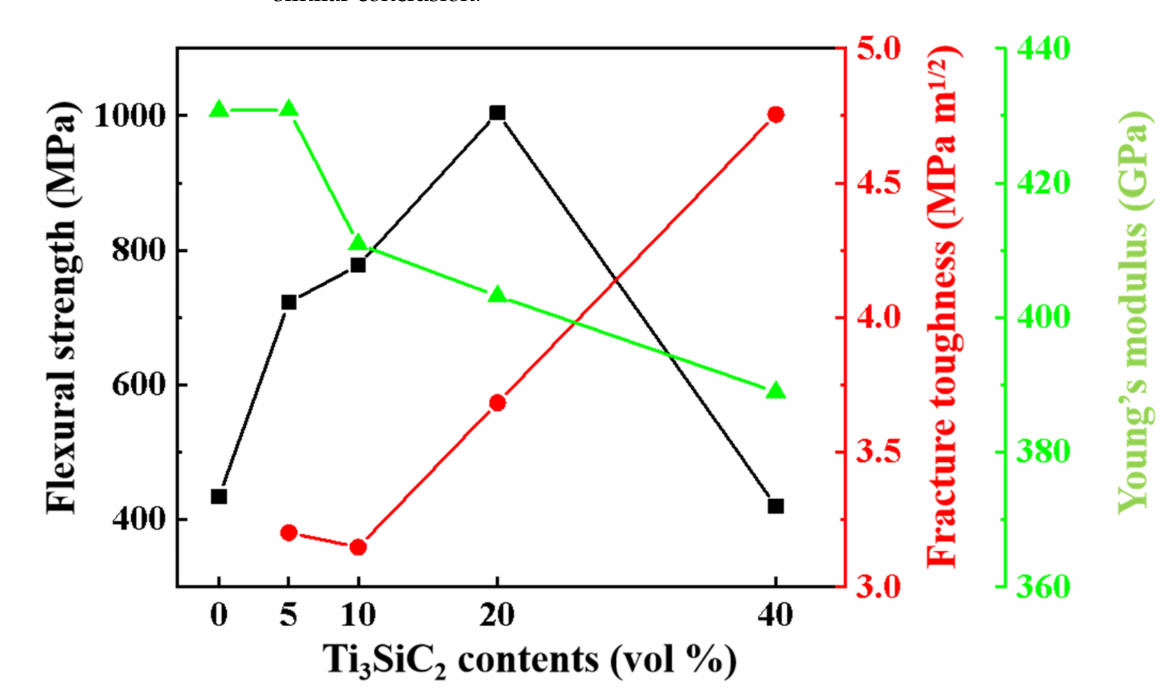
Figure 4. Mechanical properties of TiC-based ceramics with different Ti 3 SiC 2